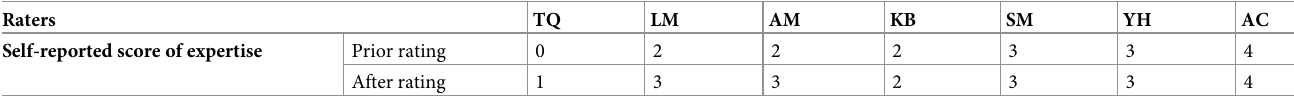
Table 2. Self-reported score of expertise for our 7 raters. Raters TQ LM AC Self-reported score of expertise Prior